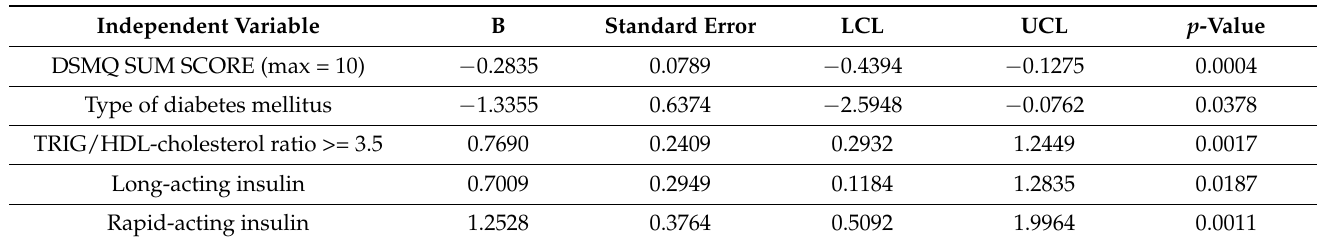
Table 4. Correlation between DSMQ Sum Score and HbA1c in a multivariate model, after step-wise elimination of